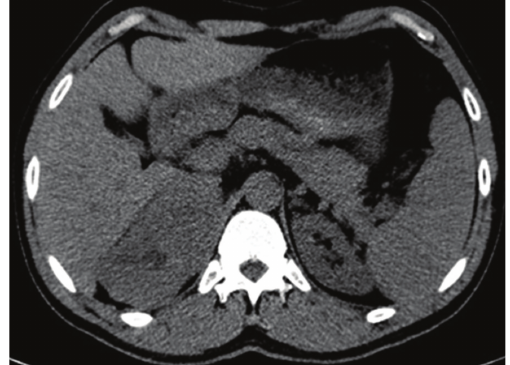
Figure 2: Axial postcontrast CT scan at CM phase shows a central patchy enhancement of the lesion displaying 160 HU, with nonen- hancing peripheral part displaying 42 HU as well as the central hypodense area, there is a hypodense right hepatic focal lesion with nodular peripheral enhancement.